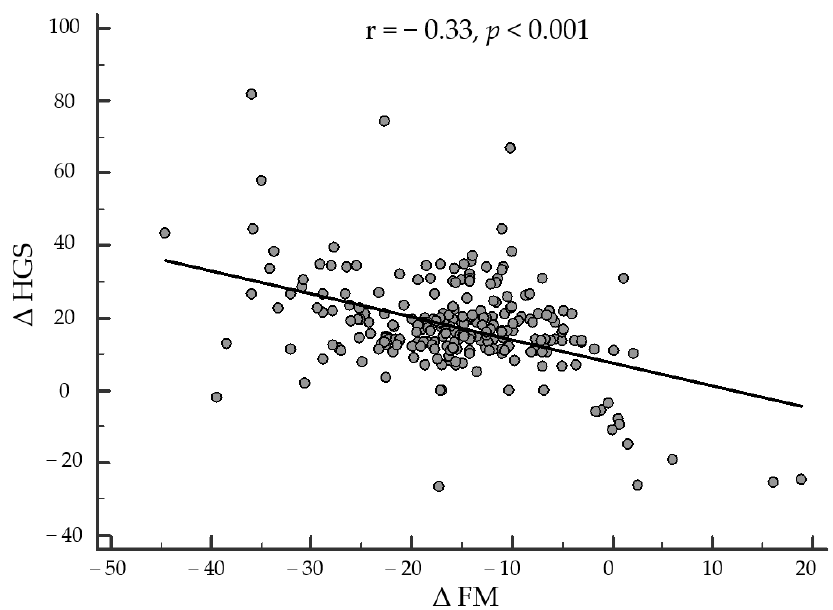
Figure 2. Correlation between changes in ∆HGS and ∆FM after adjusting for ∆BMI, ∆WC, ∆hs -CRP levels, and physical activity. After adjusting for ∆BMI, ∆WC, ∆hs -CRP levels, and physical activity, the correlation between changes in ∆HGS and ∆FM remained stati stically significant (r = − 0.331, p < 0.001). HGS, handgrip strength; FM, fat mass; BMI, body mass index; WC, waist circumference; hs-CRP, high-sensitivity C-reactive protein.